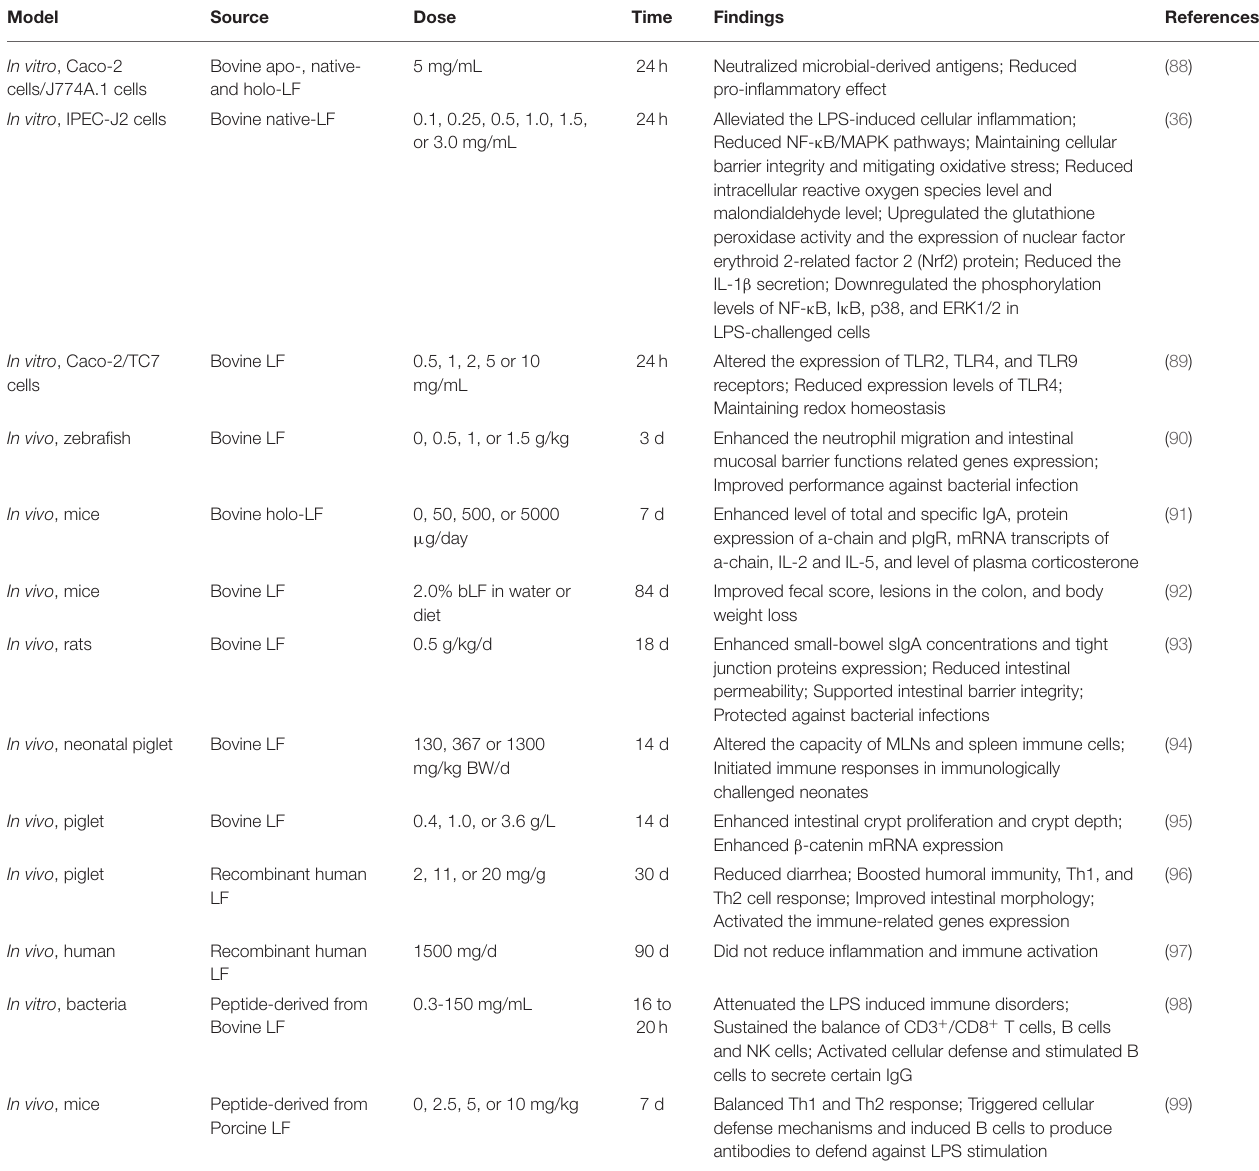
TABLE 1 | An overview of the properties of lactoferrin in the intestine mucosal immune system.